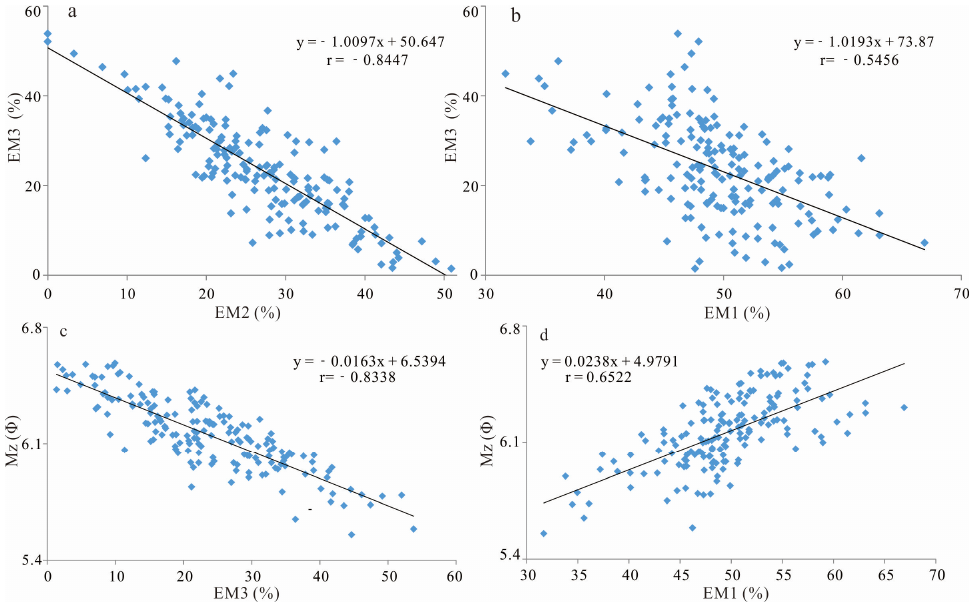
Figure 6. Correlations between ( a ) EM3 and EM2, ( b ) EM3 and EM1, ( c ) Mz and EM3, and ( d ) Mz and EM1 in the ZFS during MIS 5 period.